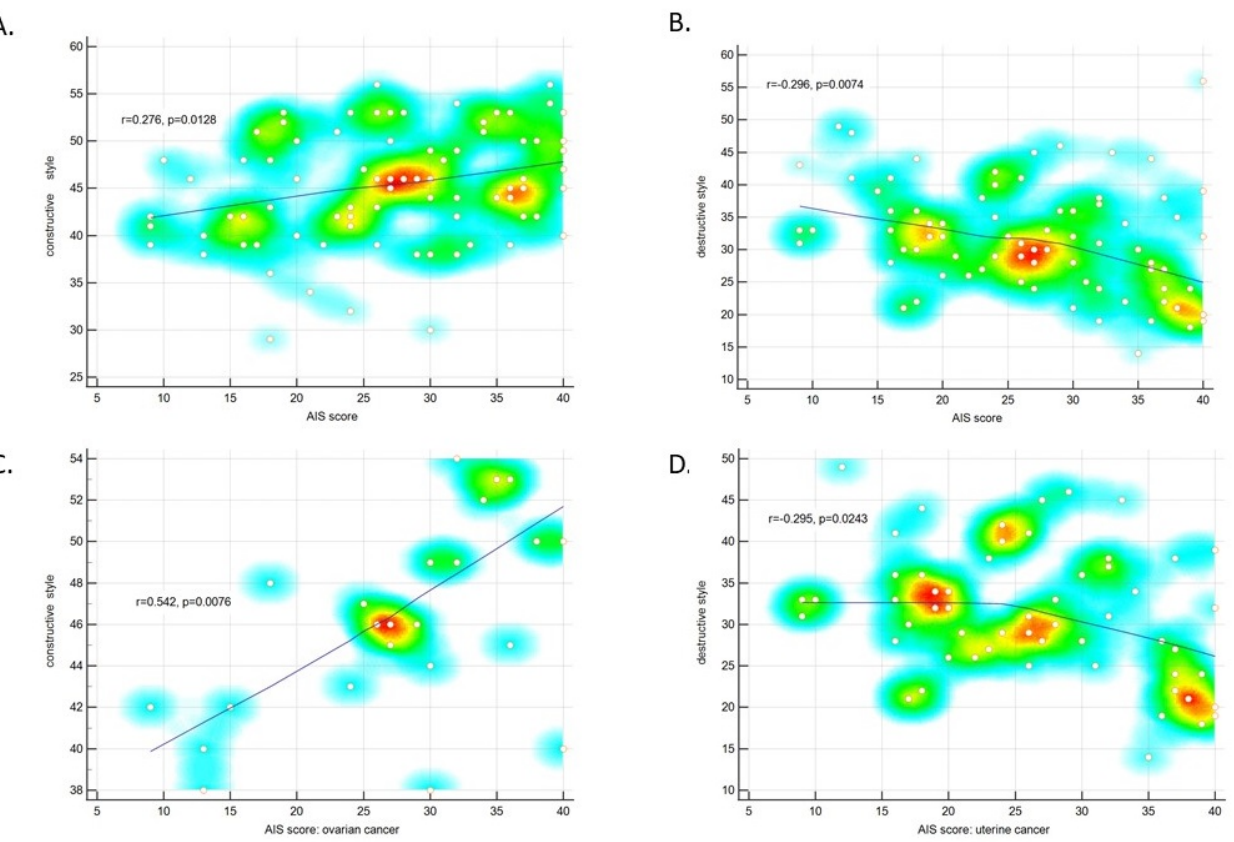
Figure 6. Correlation between the AIS scores and the intensity of mental adaptation styles: the con-